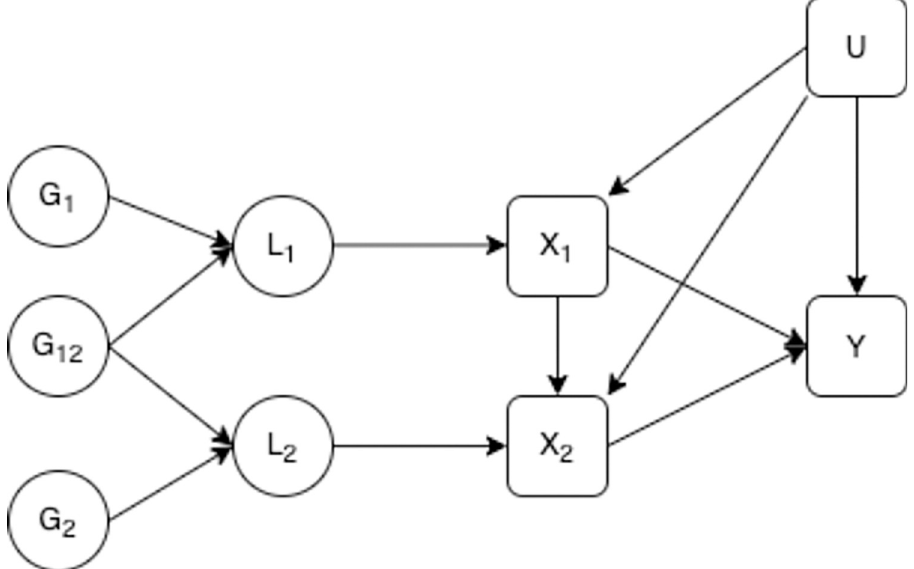
Fig 1. Liability exposure model with two periods of exposure. L 1 is the earlier liability, L 2 is the later liability, G 1 is a set of genetic variants associated with L 1 , G 2 is a set of genetic variants associated with L 2 , G 12 is a set of genetic variants associated with both L 1 and L 2 . X 1 is a measure of the exposure in the early time period X 2 is a measure of the exposure at the second time period, Y is an outcome observed at one time only, U is a set of unobserved confounders of the exposure at each time period and the outcome. X 1 and X 2 are potentially measured with error, error in this measurement is uncorrelated with the genetic